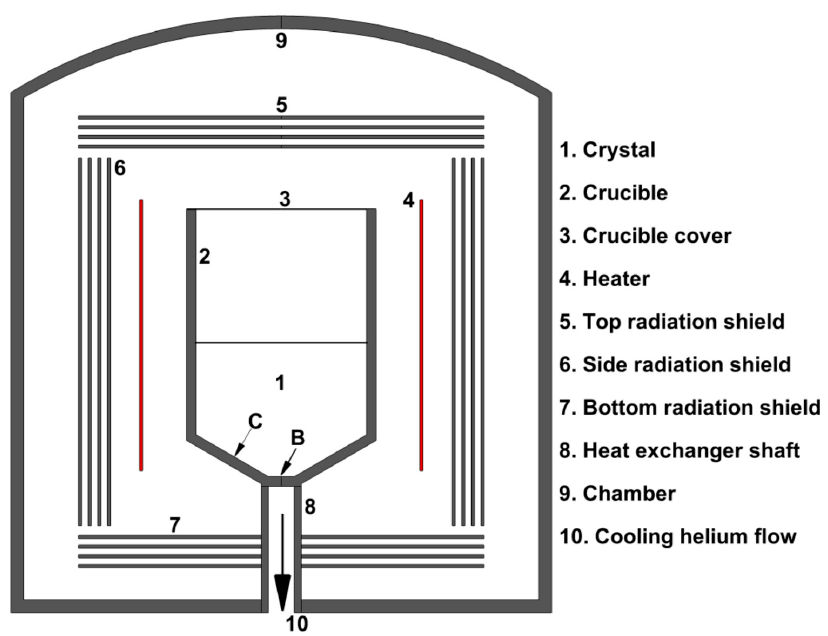
Figure 1. Schematic diagram of the heat exchanger method (HEM) furnace.